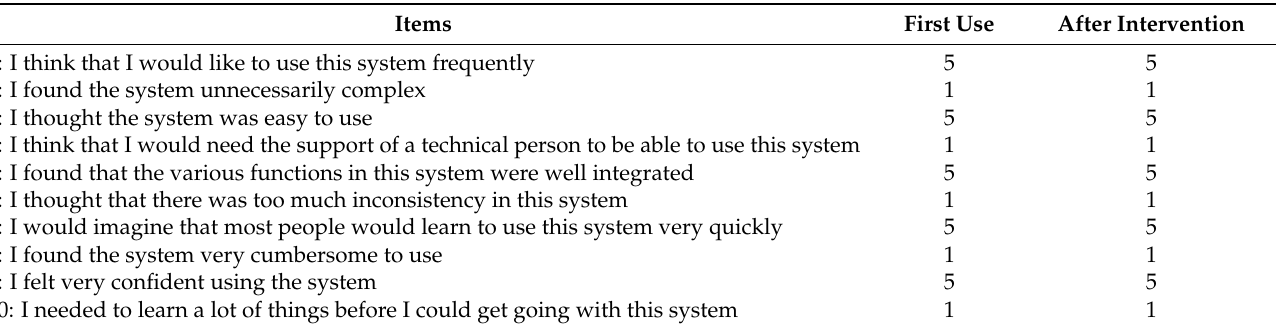
Table 3. SC/ERP + LBT-based ICT system usability